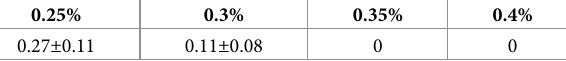
Table 6. C . sartagoforme XN-T4 bile salt tolerance. Content of bile salt